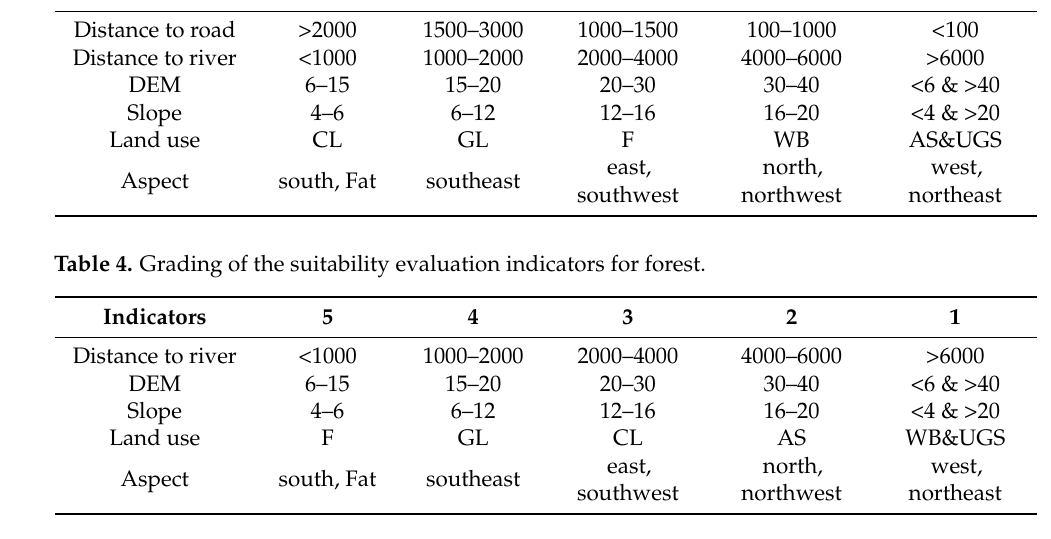
Table 5. Grading of the suitability evaluation indicators for grassland.